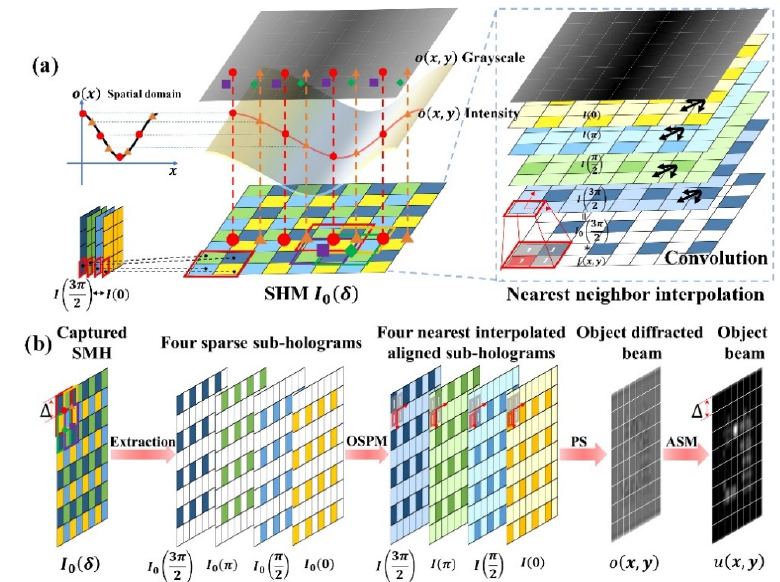
Figure 3. Proposed oversampled super-pixel method (OSPM) for PPSDH: ( a ) schematic diagram and ( b ) calculation procedure. Table 1. The classical convolutional interpolation kernels [31].